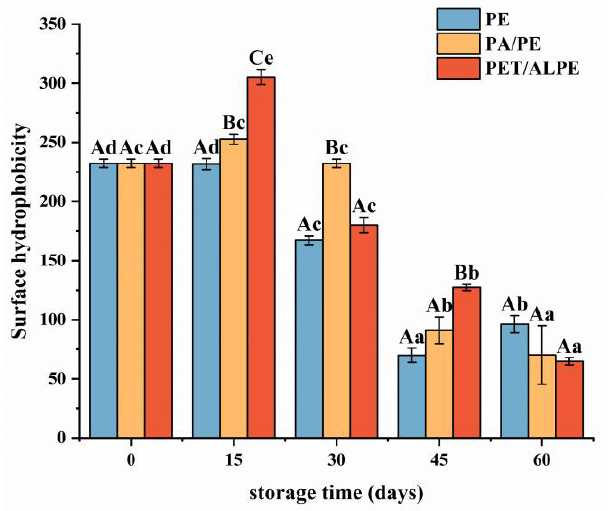
Figure 4. Effects of packaging materials on surface hydrophobicity of walnut protein at 0, 15, 30, 45, and 60 days of storage. In the figure, capital letters represent the differences among package materials in each storage period, lower letters show differences among storage periods in each package at p < 0.05 error level according to Duncan’s multiple range test. The error bar represents the standard error of the mean value.